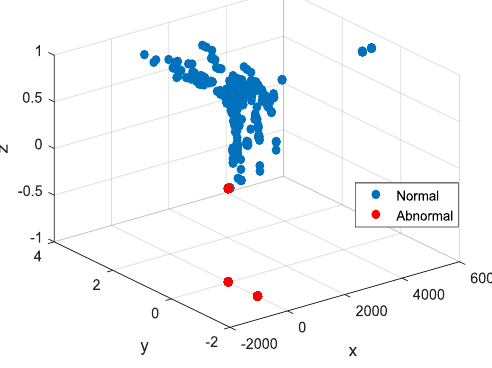
Figure 10. Data distribution after feature selection.